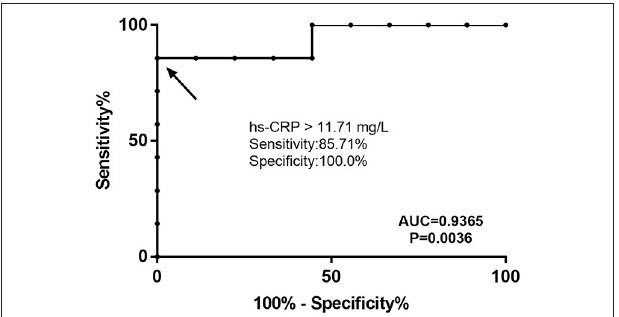
FIGURE 4 | Receiver operating characteristic (ROC) curve for hs-CRP level to distinguish patients with FGCM and FLM. The area under the curve was 0.9365. The best cutoff value for hs-CRP was 11.71 mg/L (sensitivity, 0.8571; specificity, 1.0000).